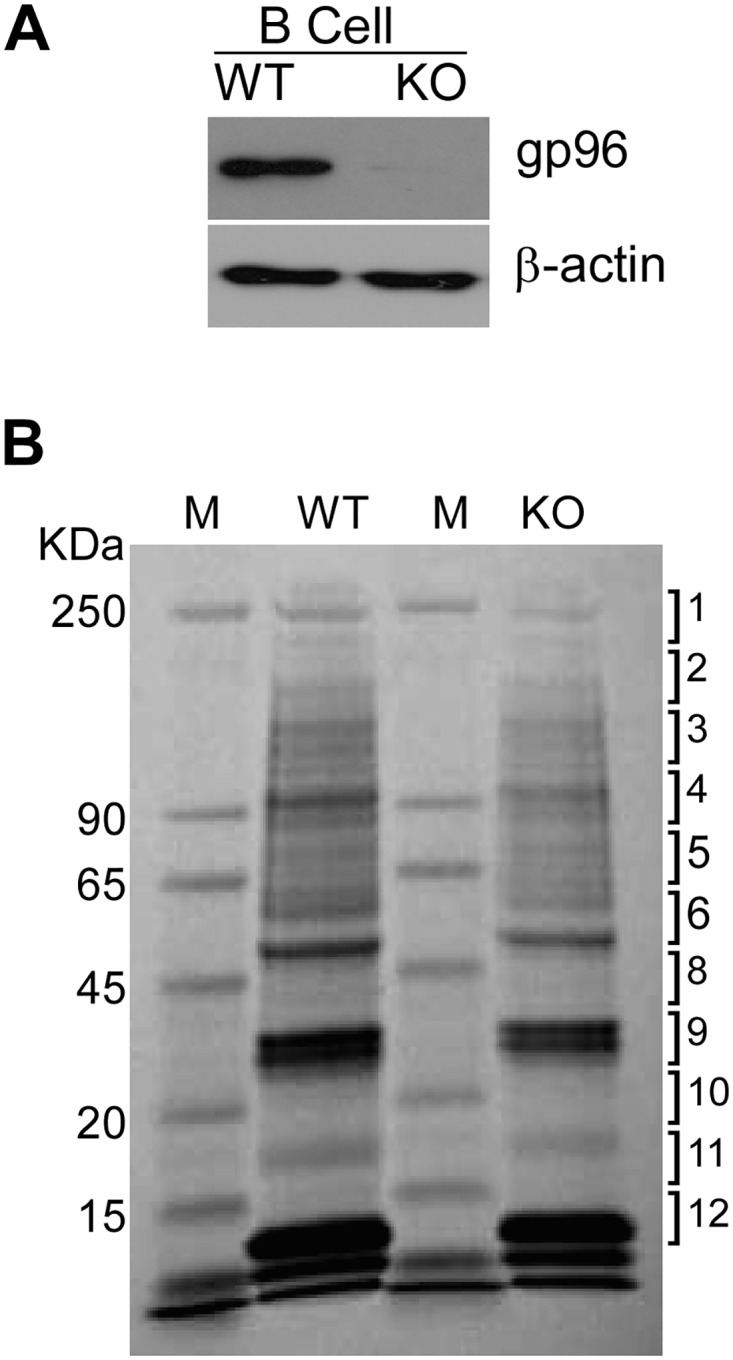
PM preparation from WT and gp96 KO B cells for protein profiling.A) Western blot of gp96 and β-action from gp96 WT and KO B cells. B) 50 μg of protein lysate was separated on SDS PAGE. The gel was stained by coomassie blue, and then cut into 12 pieces for protein identification.